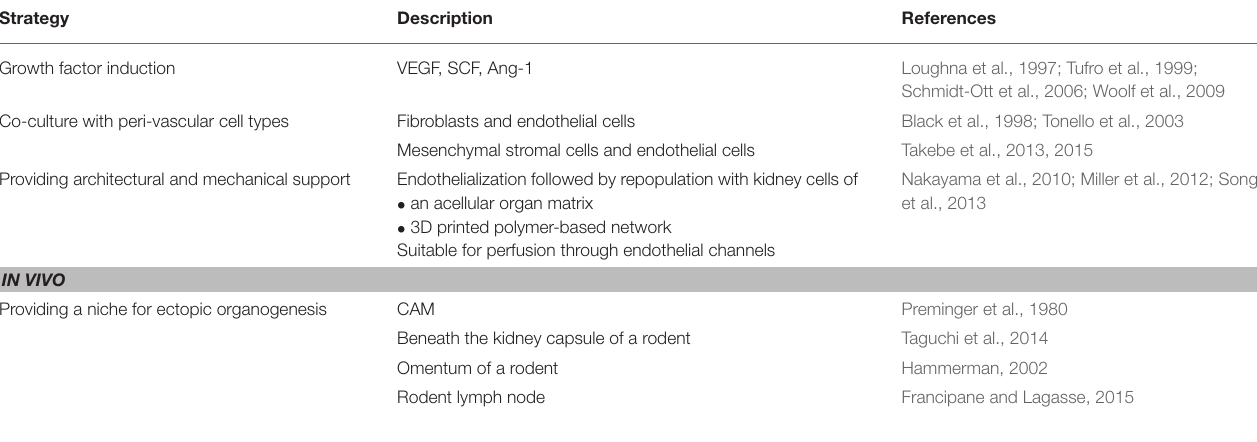
TABLE 2 | Strategies to develop a nephro-vascular